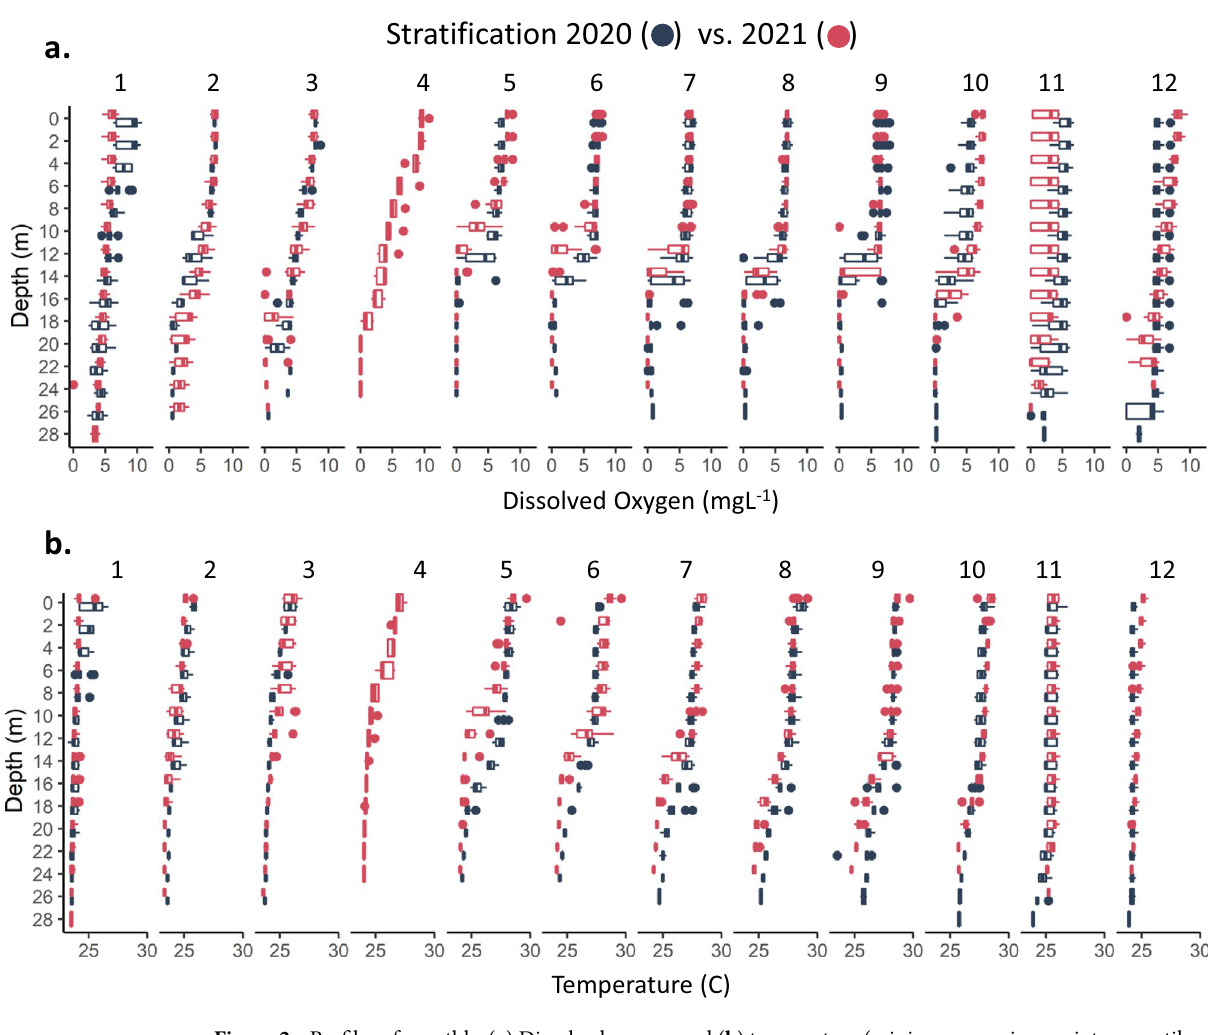
Figure 2. Profiles of monthly. ( a ) Dissolved oxygen and ( b ) temperature (minimum, maximum, inter-quartile range with outliers at 2 m